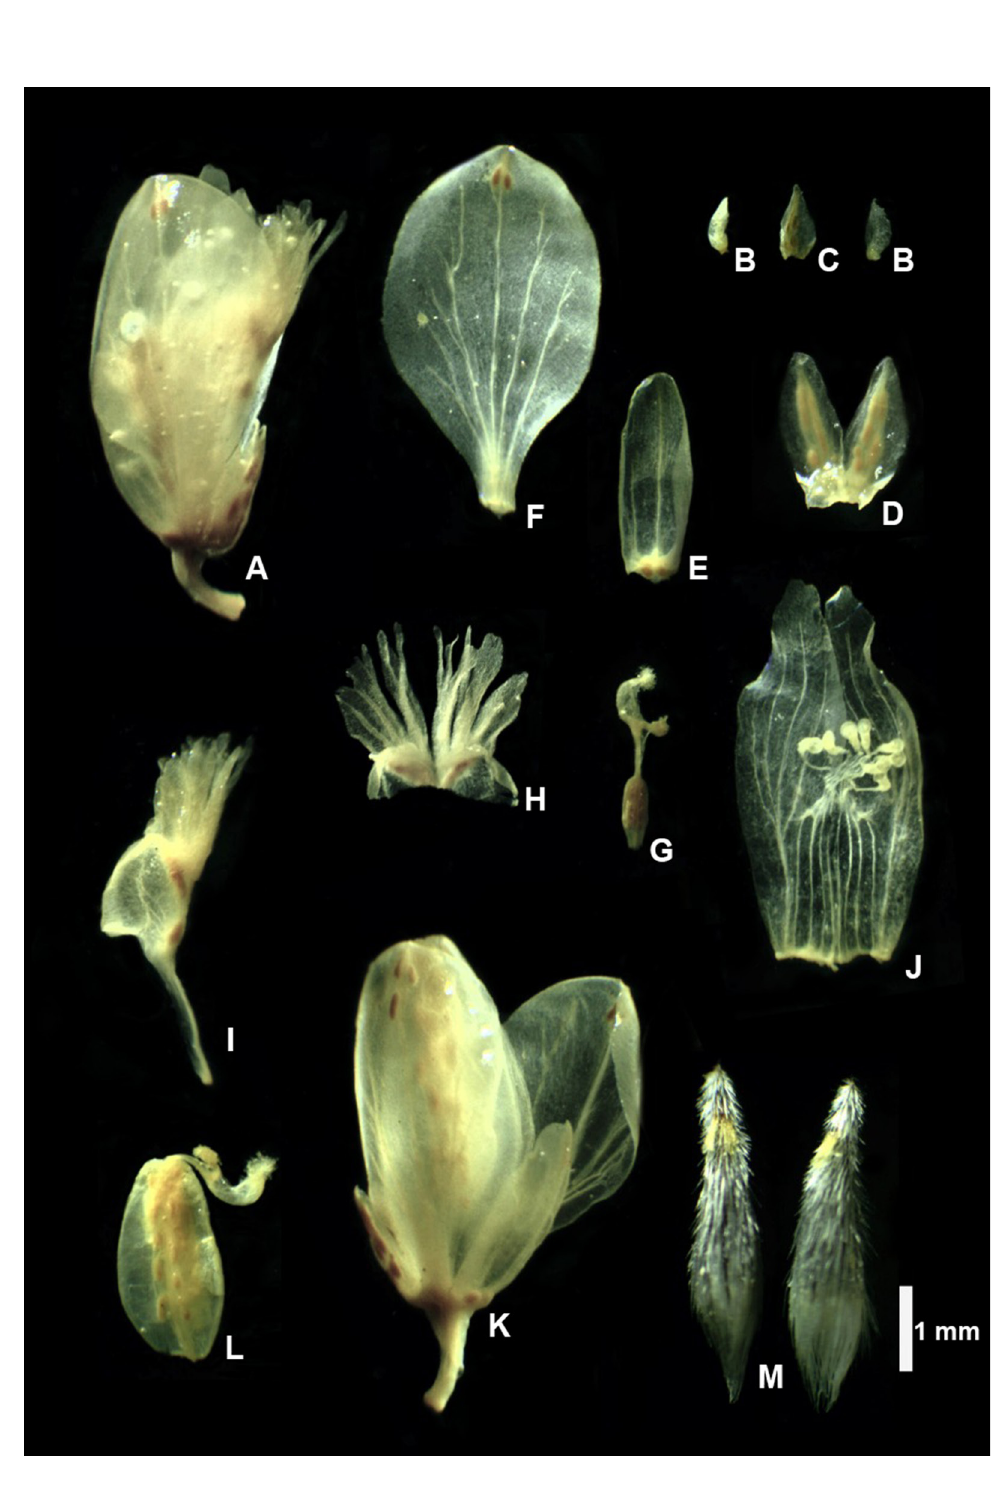
Fig. 4. Polygala tocantinensis J.F.B.Pastore & Antar sp. nov. A . Flower. B . Bracteoles. C . Bracts. D . Two upper outer sepals. E . Lower outer sepal. F . One of the two inner sepals (wings). G . Gynoecium. H . Crest. I . Keel. J . Androecium and lateral petals. K . Fruit with persistent calyx. L . Capsule. M . Seed. All from J.M. Silva, J. Cordeiro and J. Vaz 6769 . Photos: J.F.B.